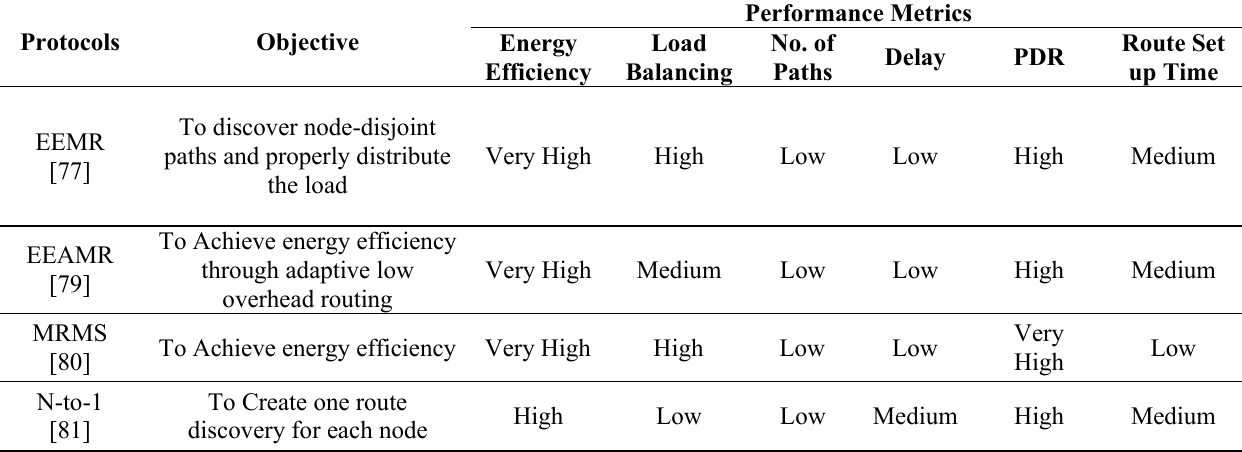
Table 10. Comparison of the Performance of Multipath Routing